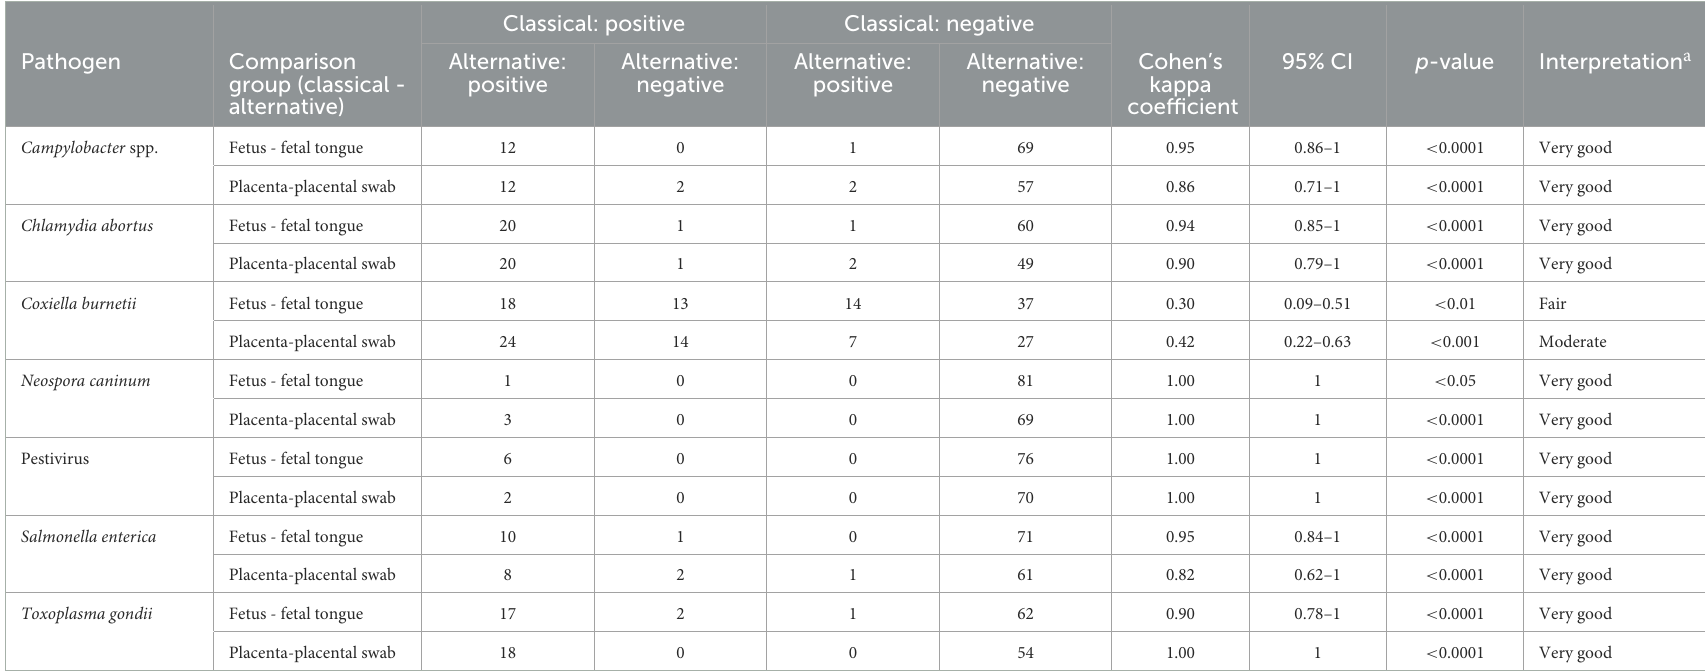
TABLE 1 Two-way contingency table for the comparison of the classical (fetus and placenta) and the alternative method (fetal tongue tissue and placental swab) for etiologic diagnosis of abortions in small domestic